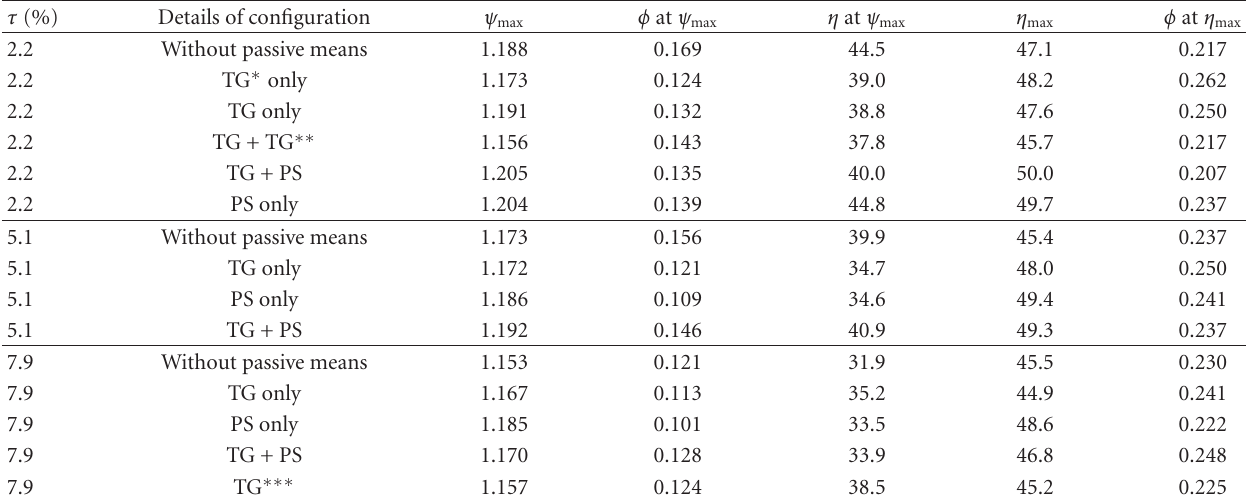
Table 3: E ff ect of configuration on